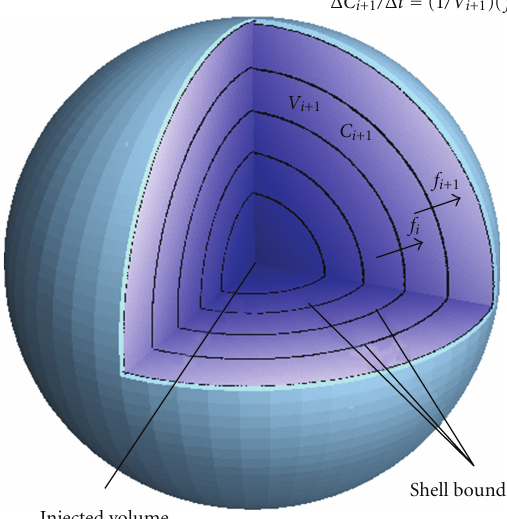
Figure 3: Injected volume with shells. Di ff usion takes place over shell boundaries, that is, the surface of the shells, and it is approximated by the balance of insulin flows entering and leaving the shell ( c : concentration; f : insulin flow; V : volume). The flows are computed according to the first Fick’s